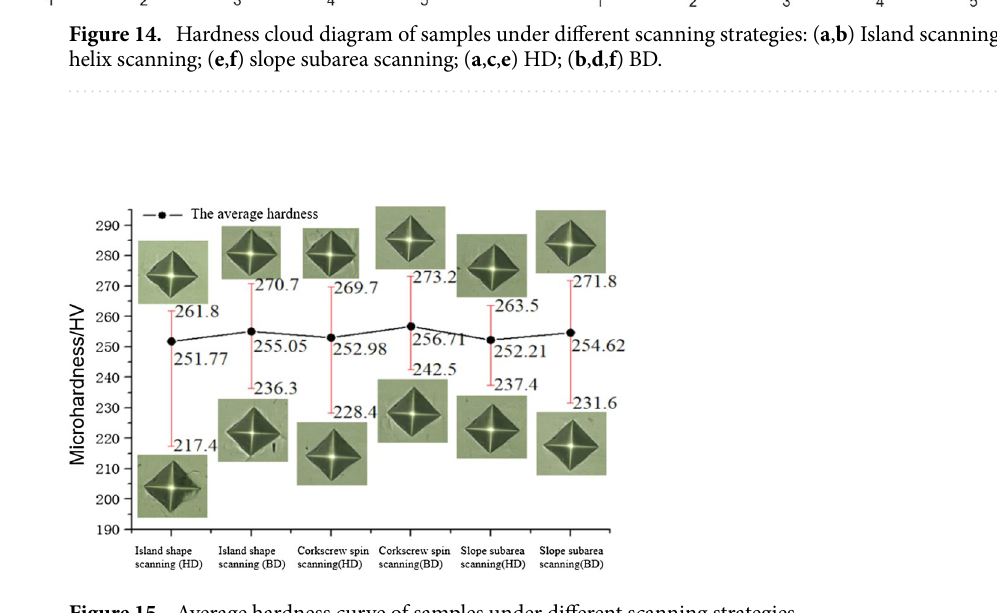
Figure 15. Average hardness curve of samples under different scanning